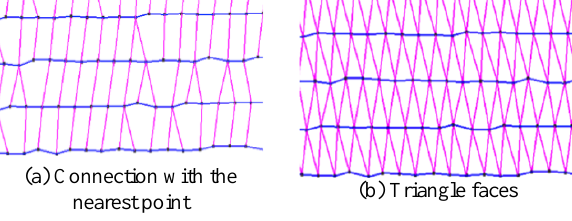
Figure 7. Generation of mesh model